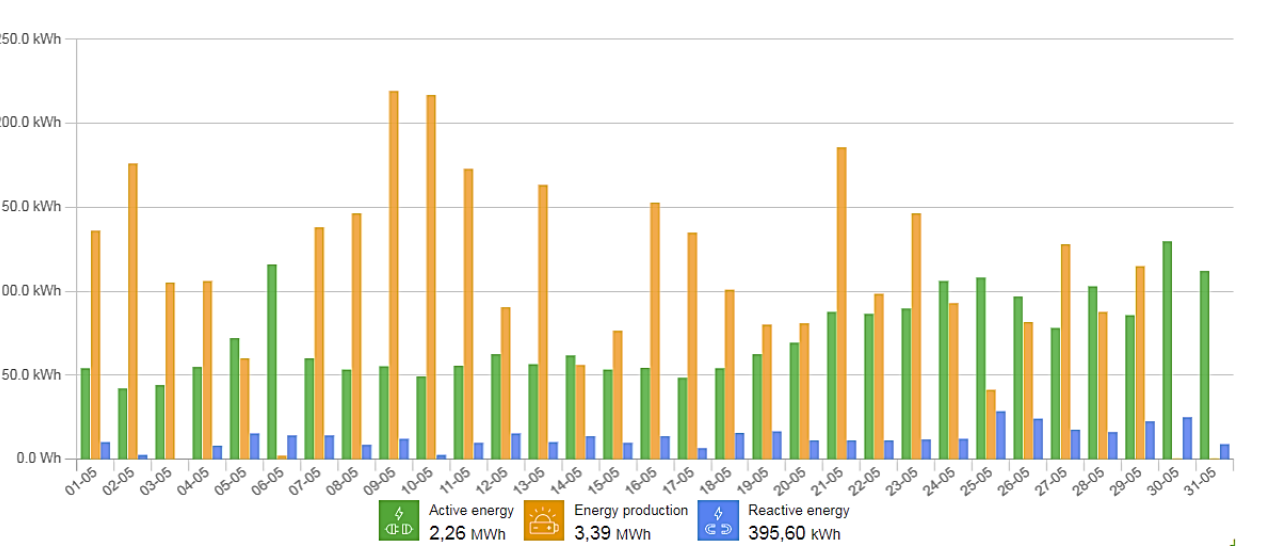
Figure 10. Electric vehicle charger installed for Sector 5 in the LSTP. The amount of energy produced by the PV system and transferred to the power grid allows the traction batteries in several electric vehicles to be fully charged. The Renault Zoe shown in Figure 10 has a battery with an energy capacity of 40 kWh. This means that it is possible to fully charge it up to five times with the energy produced on 9 and 10 May 2020 (see Figure 12). It is relevant to mention that the vehicle can travel 300 km on a full battery. LPNT authorities have decided that it is better to use the energy produced to charge BEV than to resell it at low prices. The marketing effect related to supporting electro mobility by the LSTP will be more beneficial for the institution. In addition, it will